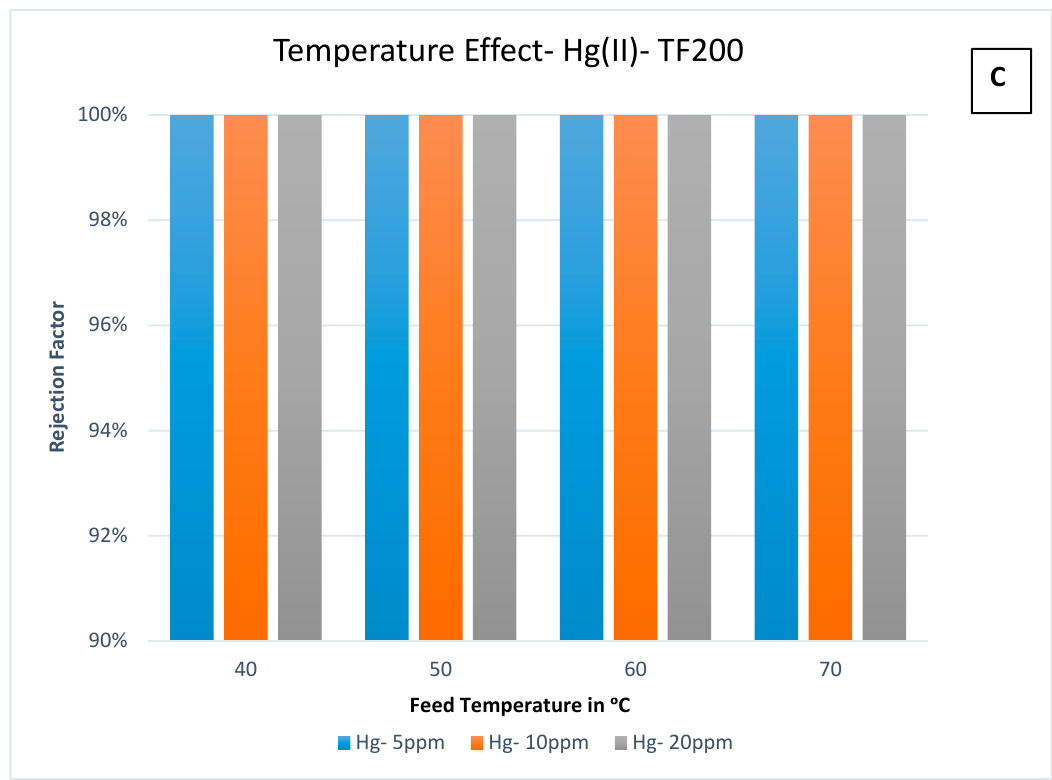
Figure 7. Effect of feed temperature on the rejection factor for TF200 membrane: ( a ) Pb(II), ( b ) As(III) Figure 7. E ff ect of feed temperature on the rejection factor for TF200 membrane: ( A ) Pb(II), ( B ) As(III) and ( c ) Hg(II) (coolant temperature = 10 °C, flow rate = 3 L/min). and ( C ) Hg(II) (coolant temperature = 10 ◦ C, flow rate = 3 L / min). Water 2020 , 12 , x FOR PEER REVIEW